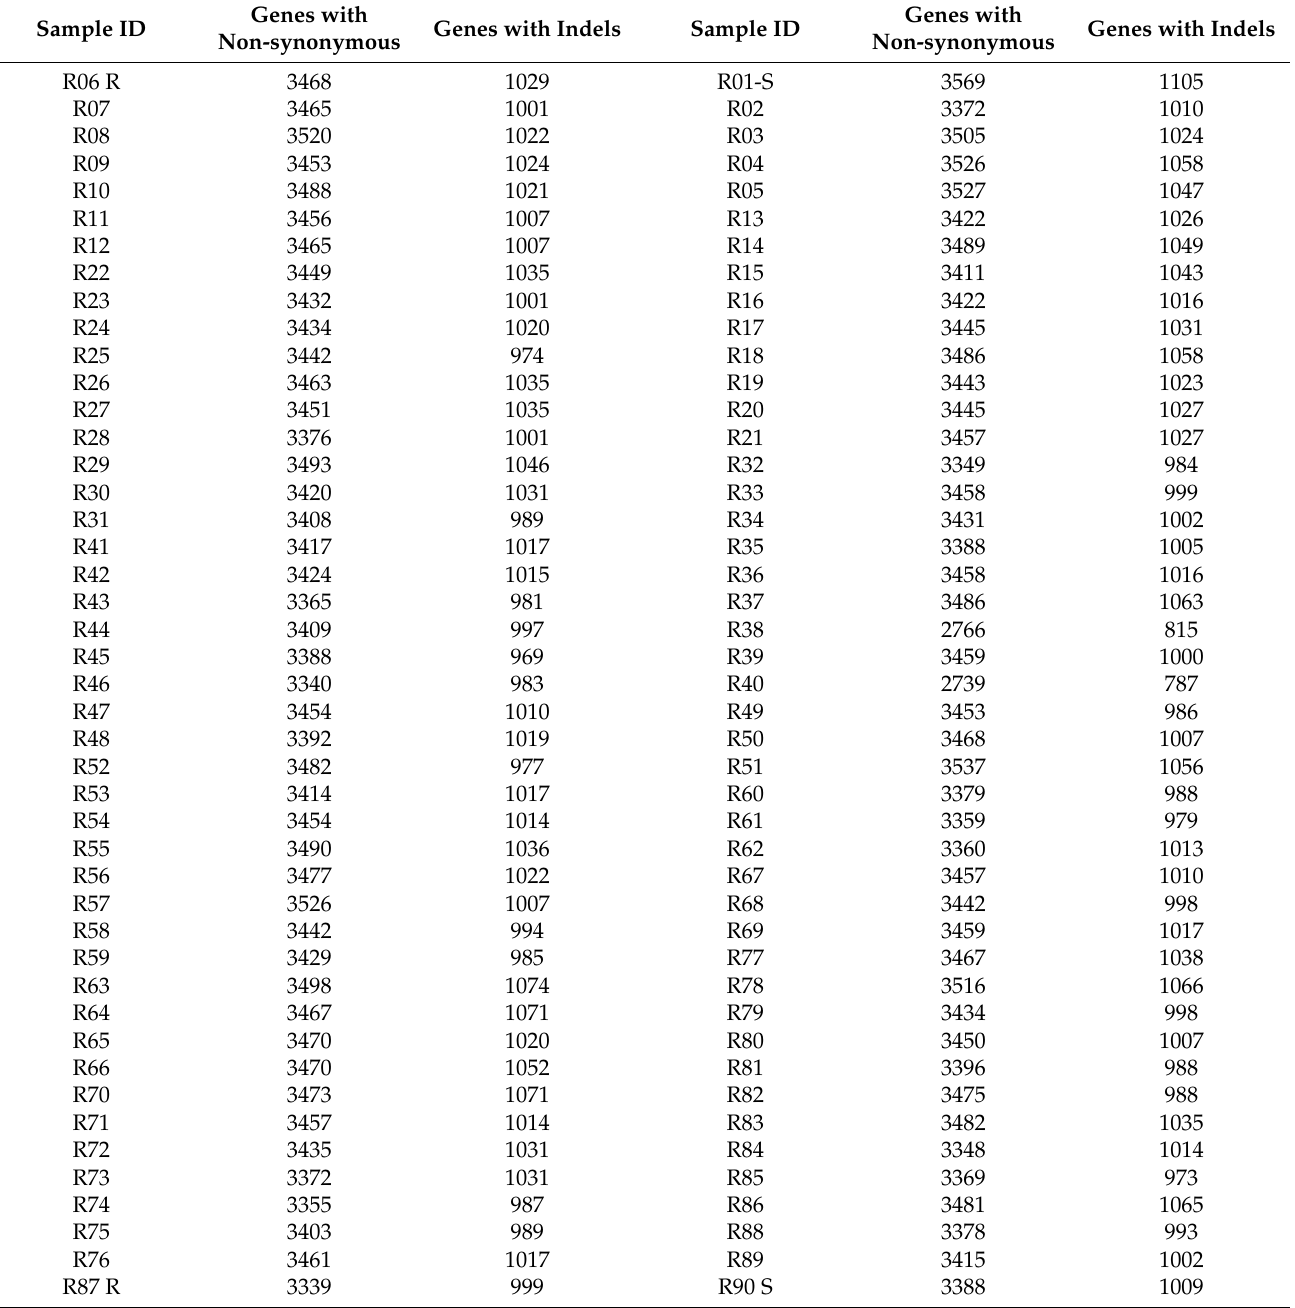
Table A3. Classification statistics of differentially expressed genes produced by 45 resistant and 45 susceptible samples in A. c. cerana